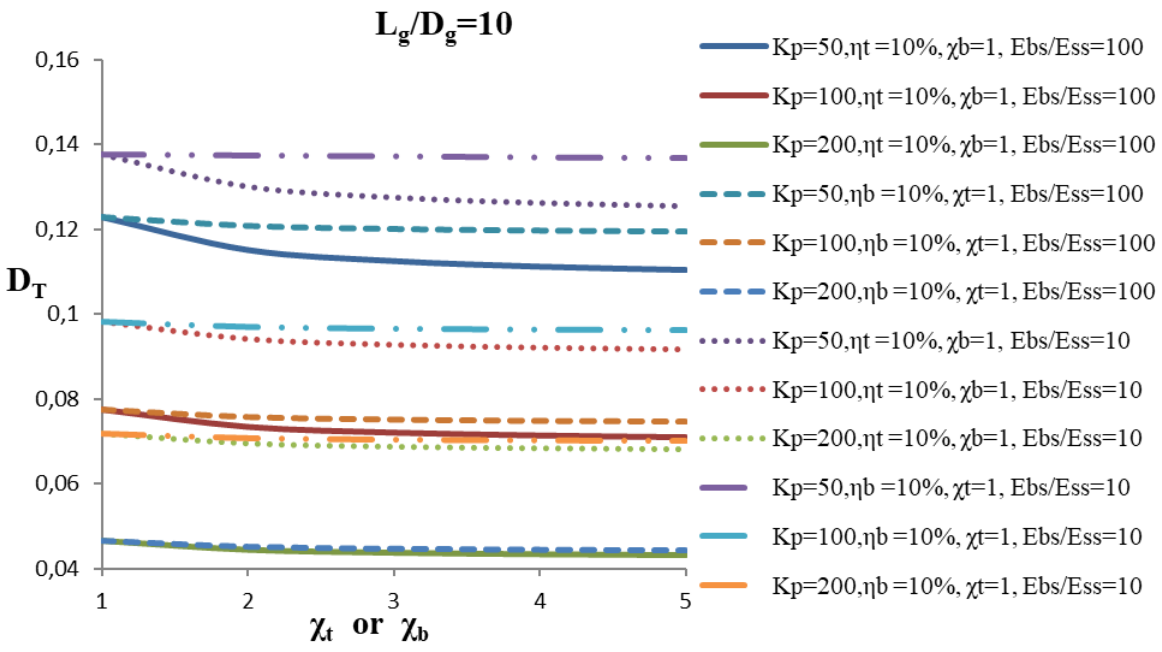
, with strengthening factor for the top, χ T ; PLST of GP, η ; PLSB of GP, η p t /D =10, η or η g g t b